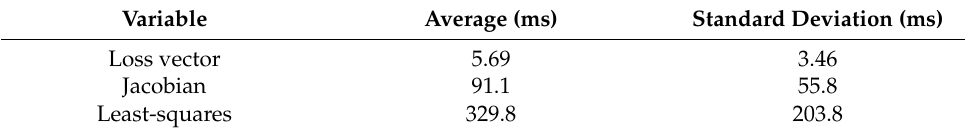
Figure 6. Breakdown of computation time for the trajectories solved in Figure 2a. Each bar represents the total computation time (all nonlinear least-squares iterations). On average, the evaluation of the loss vector (Equation (20)), the Jacobian, and the nonlinear least-squares represent 1.3%, 21.4%, and 77.3% of the computation time, respectively. A further breakdown of the computation time statistics is provided in Table 3. Table 3. Statistics associated with the computational breakdown given in Figure